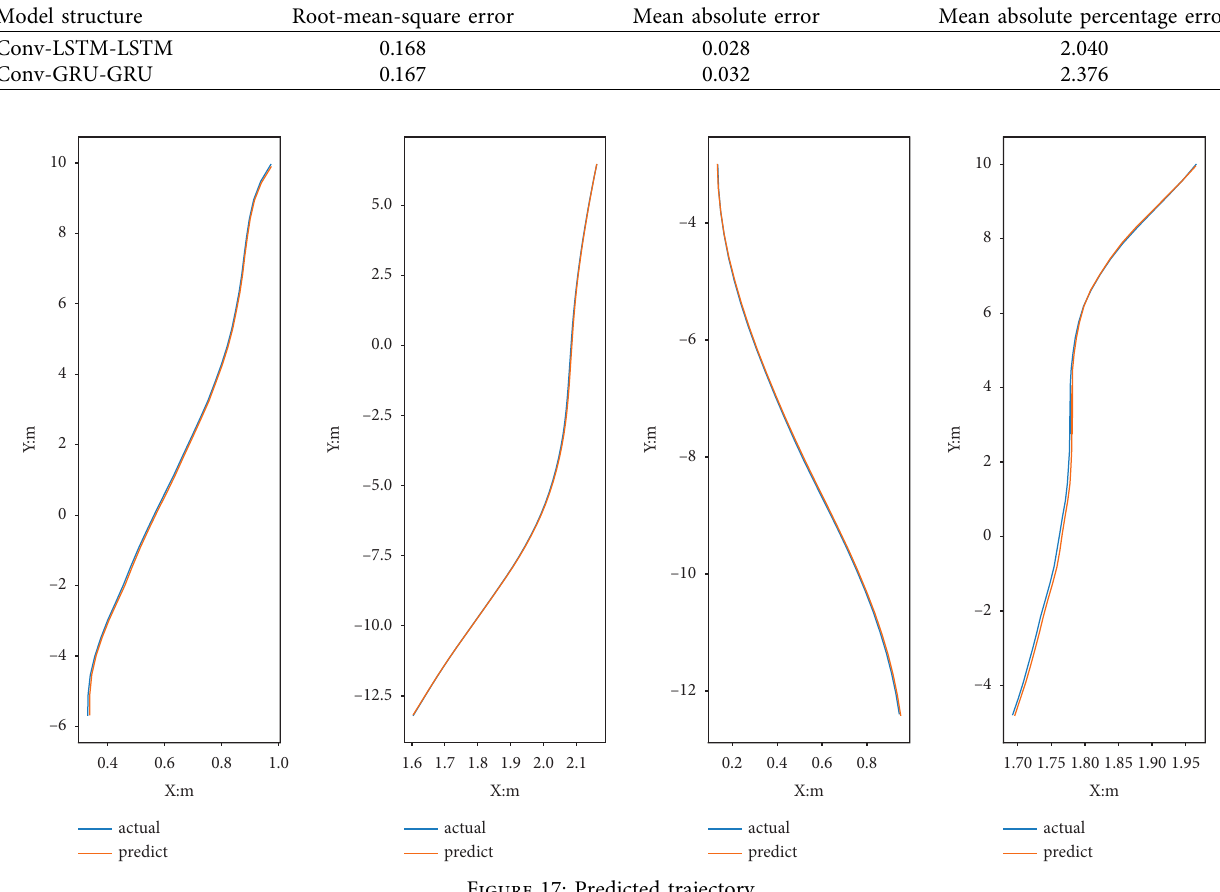
Table 2: Comparison of model accuracy.